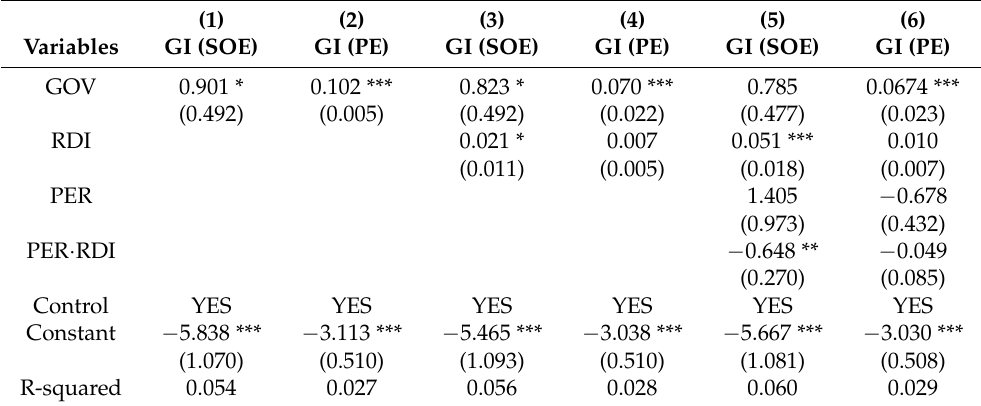
Table 6. Regression results based on heterogeneity of